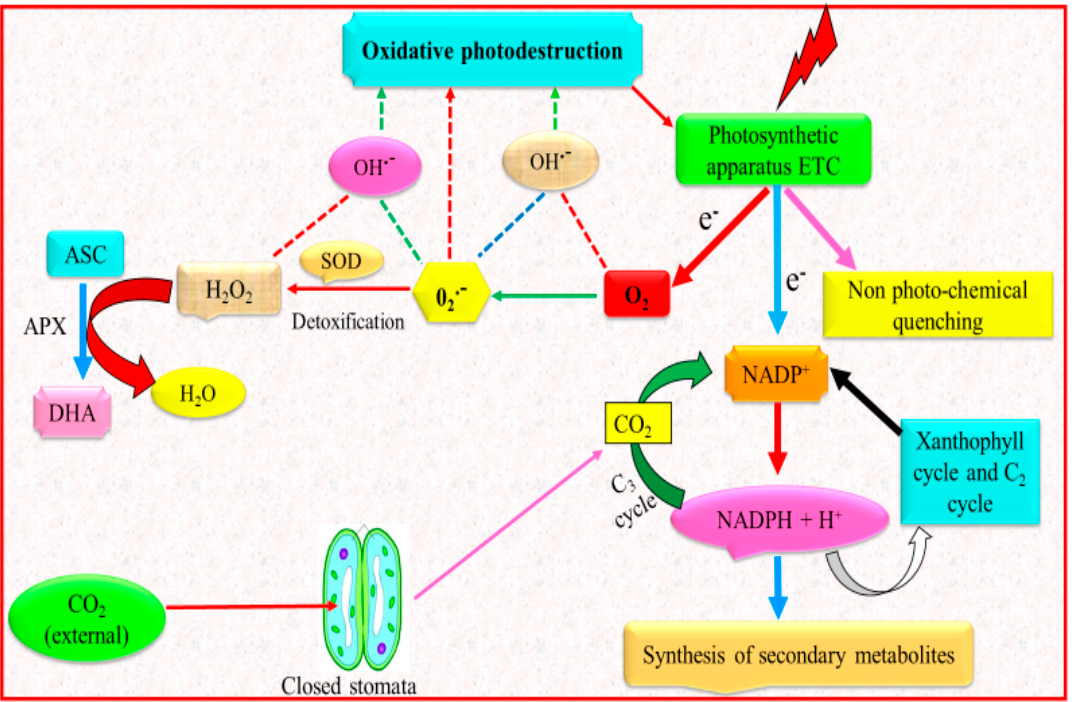
Figure 3. Enhanced synthesis of secondary metabolites under drought stress. Light energy captured by the photosynthetic machinery is considerably greater than the energy essential for the CO 2 fixation. Energy dissipation takes place by non-photochemical quenching and re-oxidation of NADPH + H + , i.e., via xanthophyll cycle and C 2 cycle. Endogenous CO 2 level is low because of the escalated diffusion resistance caused by closing of stomata. Hence, a smaller amount of NADPH + H + is utilized in the C 3 cycle for the fixation and reduction of CO 2 , and, ultimately, a greater amount of energy has to be dissipated. Protective activities such as non-photochemical quenching, C 2 cycle and xanthophyll cycle are boosted by feedback mechanisms; a number of e − is transported to O 2 (Mehler reaction). Generation of O 2 •− ions further produce various ROS. Due to the stress-associated stimulation of SOD and APX, detoxification of the O 2 •− ions occurs and therefore results in reduction of generation of ROS. Greater enhancement in the reduction potential, i.e., the ratio of NADPH + H + to NADP + , elevates the plants secondary metabolites synthesis (modified from Kleinwächter and Selmar [90]).